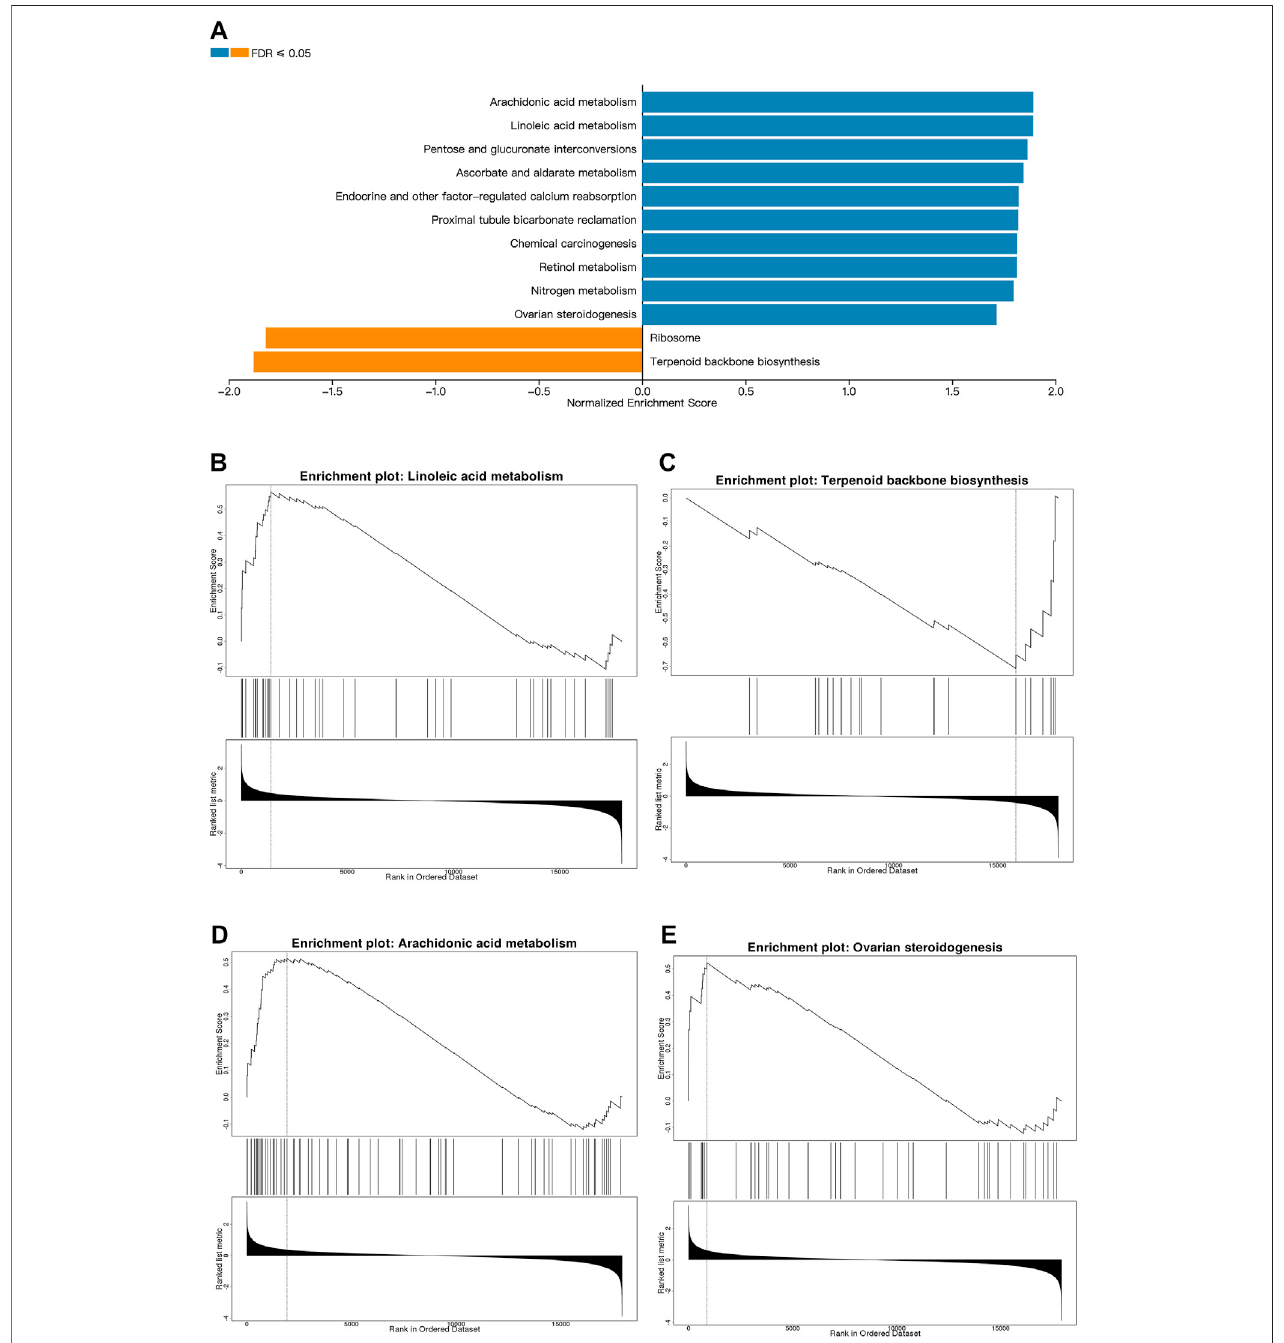
FIGURE 6 | Metabolic pathways affected by EMP. (A) The top Reactome gene sets that are up- and down-regulated with respect to EMP treatment based on normalized enrichment scores (NES) for EMP/HFD genes. (B – E) Pathways related to lipid metabolism and synthesis which are selected from (A) . (orange: upregulated pathways, blue: downregulated pathways, FDR ≤